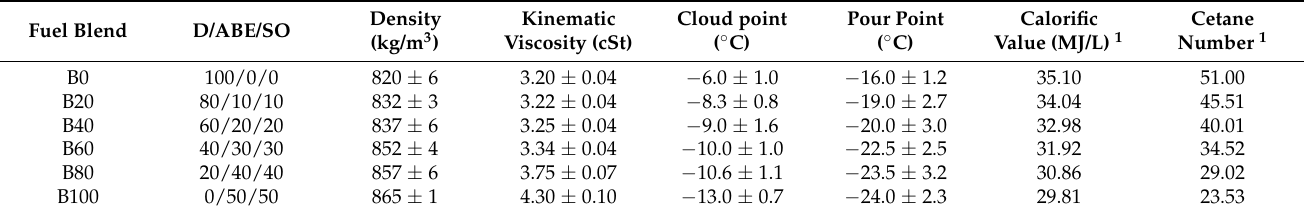
Table 5. Viscosity values at 40 ◦ C (cSt, centistokes), density, cloud point, pour point, calorific value, and cetane number of the diesel/ABE/sunflower oil blends, obtained by adding different amounts of ABE/sunflower oil double blend, containing 50% ABE, to diesel. Errors are always calculated as standard deviation from the average of three measurements.